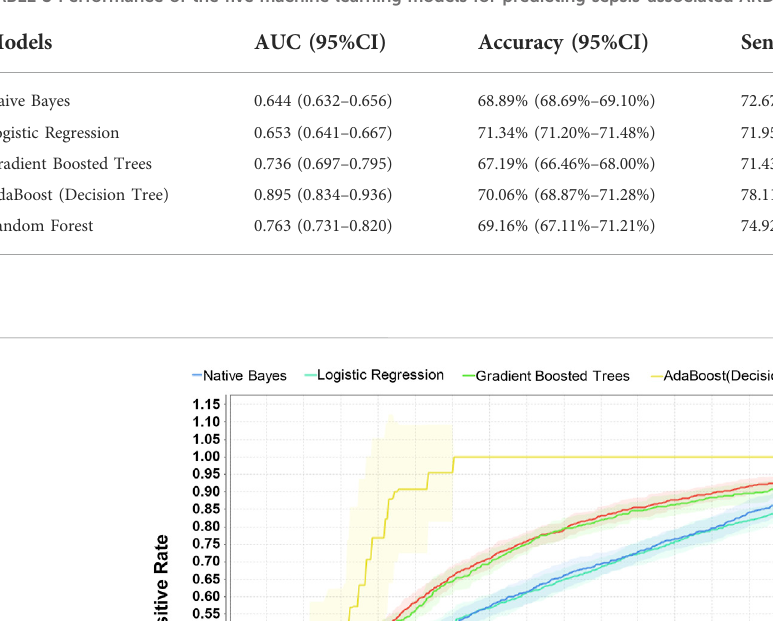
TABLE 3 Performance of the fi ve machine learning models for predicting sepsis-associated ARDS.